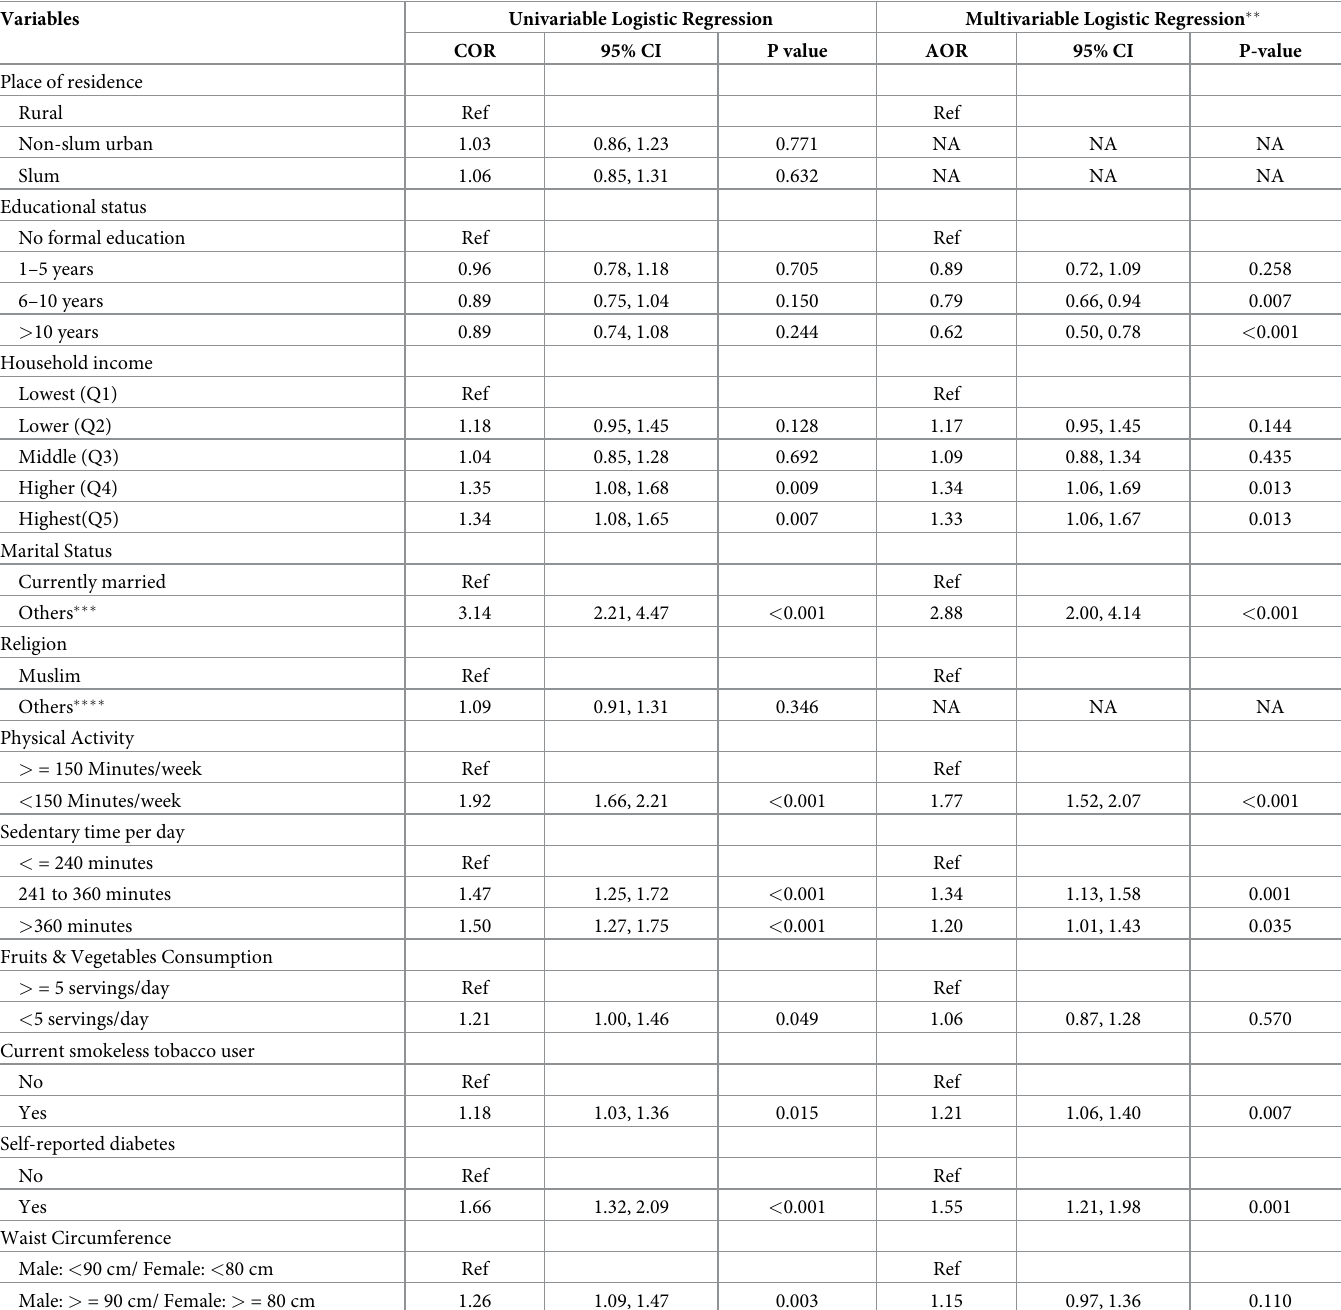
Table 3. Univariable and multivariable logistic regression results with potential determinants of elevated CVD risk � 10% (for males) �